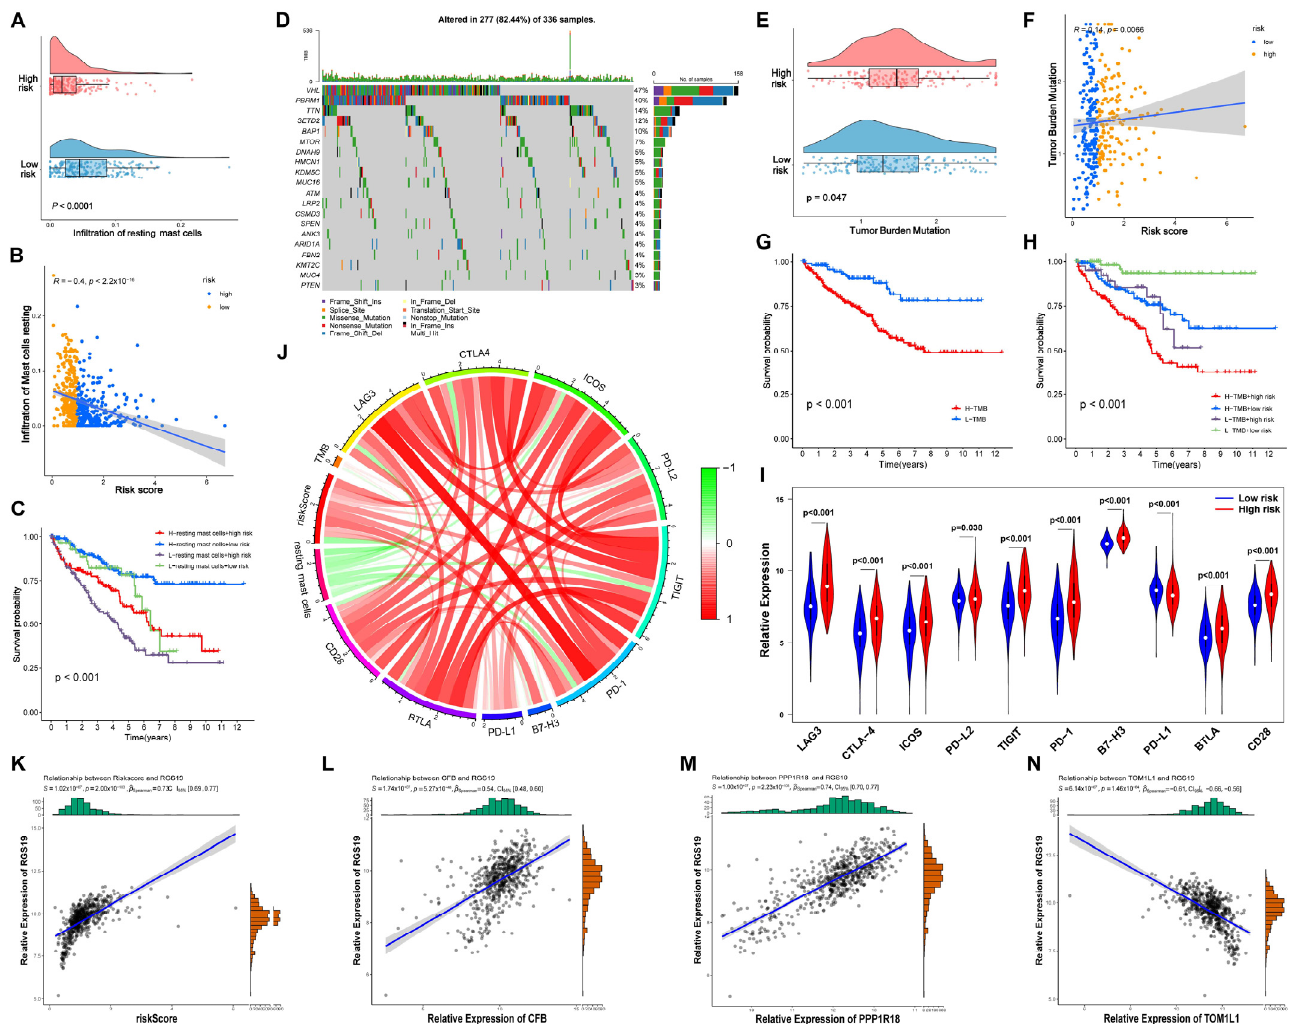
Figure 10. R elationship of the prognostic panel with immune-predicting factors and autophagy- related genes. ( A , B ) The risk model was significantly negatively linked with the infiltration of RMCs ( p < 0.001). ( C ) The integration of risk score and RMC infiltration presents a great prognostic value ( p < 0.001). ( D ) Waterfall plot illustrates the highly mutated genes. ( E , F ) The risk signature was significantly positively related to the TMB ( p < 0.001). ( G ) OS curves of the high- and low-TMB patients. ( H ) The combination of the risk score and the TMB presents a significant prognostic value ( p < 0.001). ( I ) The distinct expression of representative immune checkpoint genes in high- and low-risk patients. ( J ) Circle diagram exhibits the correlation among the prognostic panel, RMCs, TMB, and immune checkpoint genes. Scatter plot displays the relationship between RGS19 and the risk score ( K ), CFB ( L ), PPP1R18 ( M ), and TOM1L1 expression ( N ). p < 0.05 was considered statistically significant. TMB, tumor mutation burden.